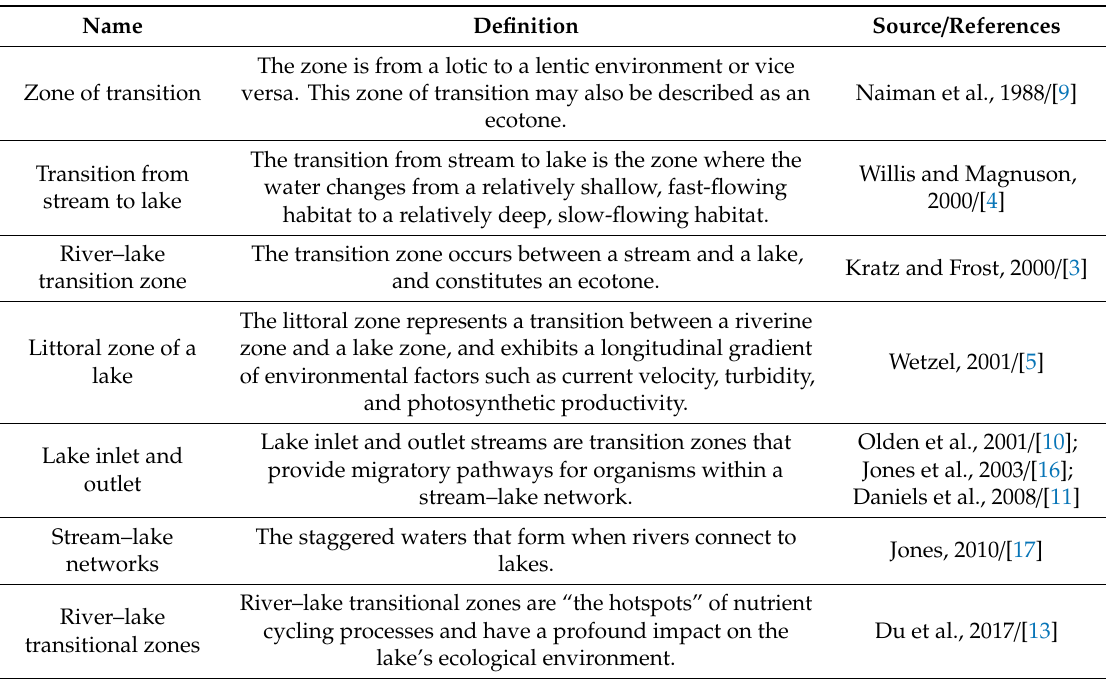
Table 1. Definitions of the river–lake transition